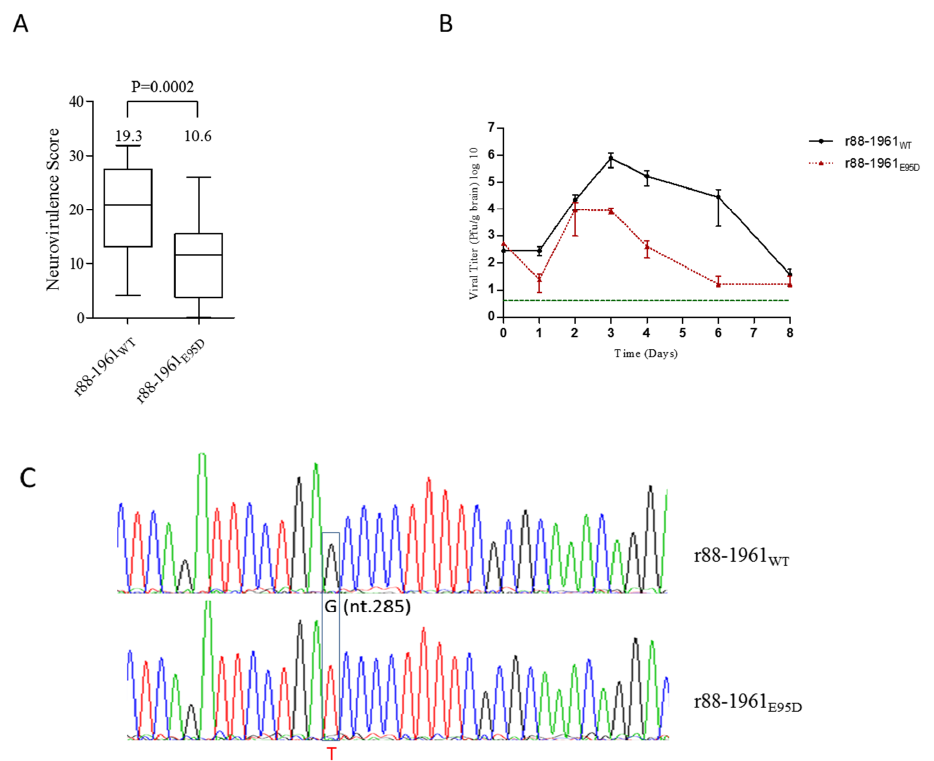
represent the median scores. The mean scores for each virus are indicated at the top of each plot. ( B ) Newborn rats (5 animals per time point) were inoculated intracerebrally with r88-1961 WT and